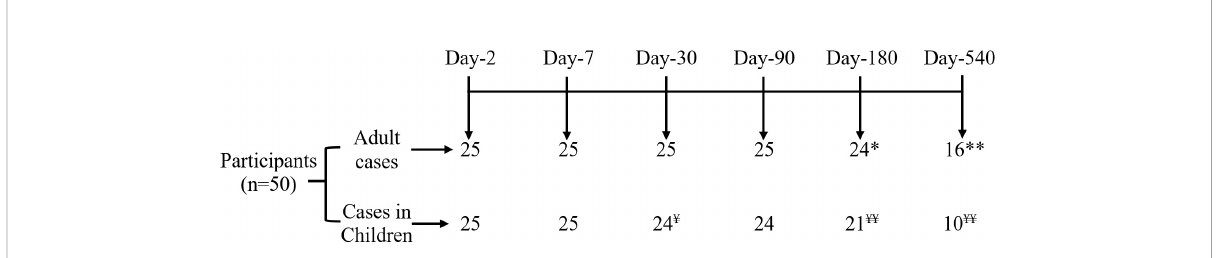
FIGURE 1 Consort diagram of participant disposition. *Refuse to continue study at day 180 (n=1) and **migration out at day 540 (n=8); ¥ Refuse to continue study at day 30 (n=1) and ¥ ¥ migration out on 180 (n=4), and 540